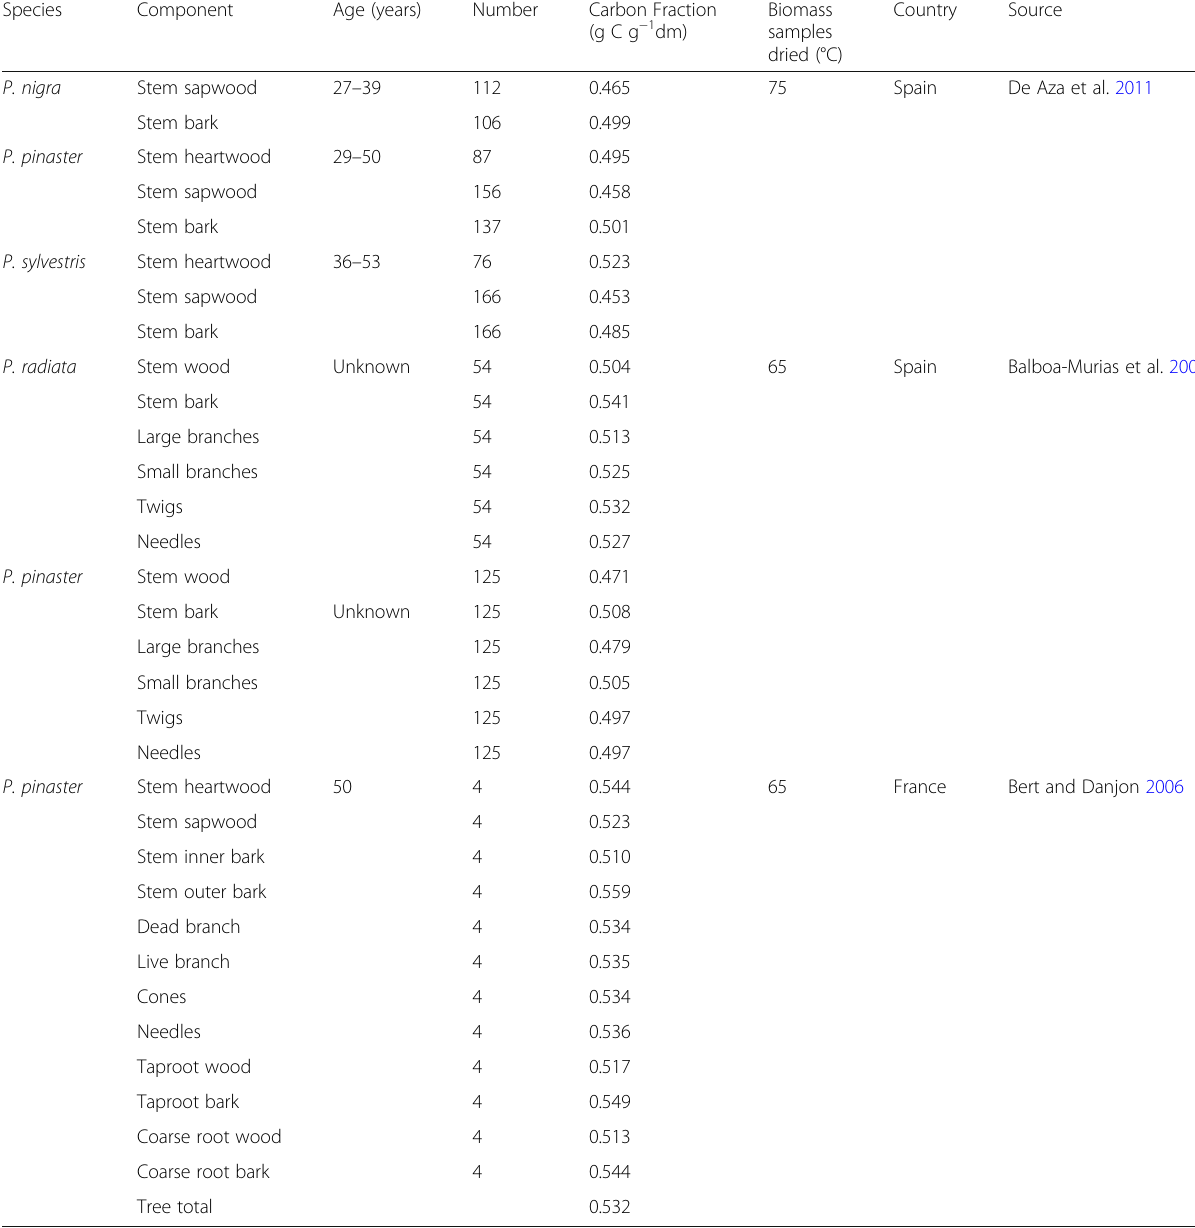
Table 5 Component carbon fraction, number of sample trees per stand ( n ), country of study and source of data for various Pinus species